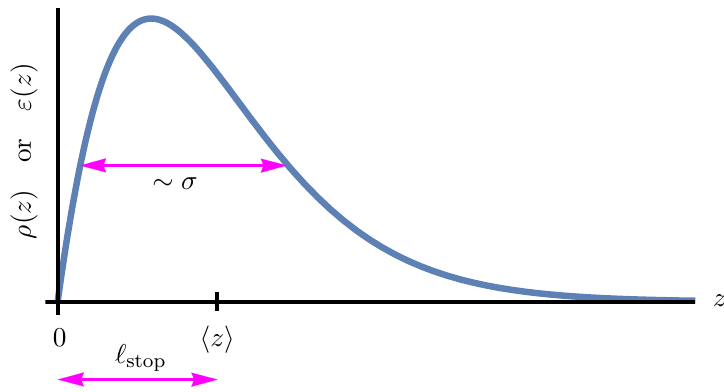
Figure 7 . The stopping distance and width characteristic of where charge or energy is deposited by a shower. (The above curve is presented here for qualitative purposes, but the shape depicted just happens to be the precise leading -order numerical result for QED charge deposition (cid:26) ( z ) | see appendix B. In that case, the speci(cid:12)c \ (cid:24) (cid:27) " line shown above has length 2 (cid:27)